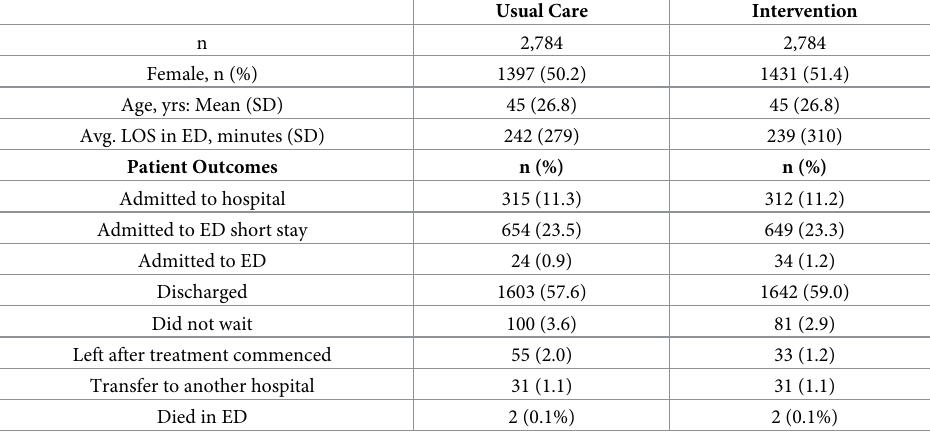
Table 1. Demographic details of the study